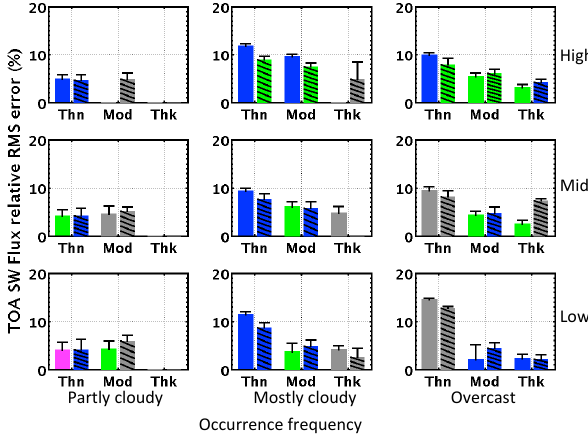
Figure 16. Same as Fig. 15, but over